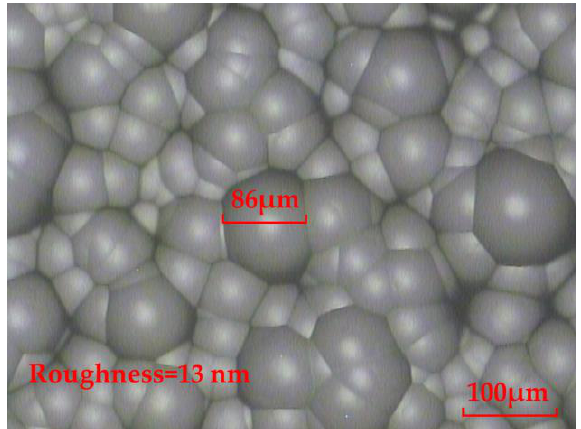
Figure 6. Microscopic image of the honeycomb rMLA.